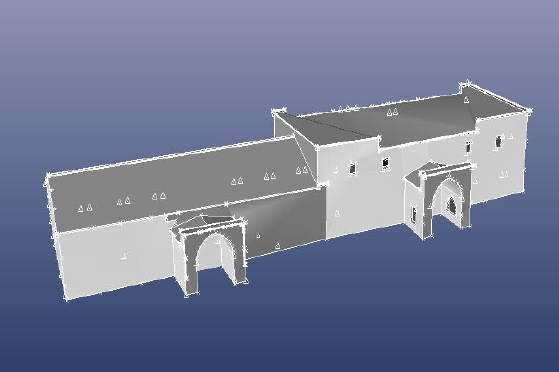
Figure 4. Control points and surfaces